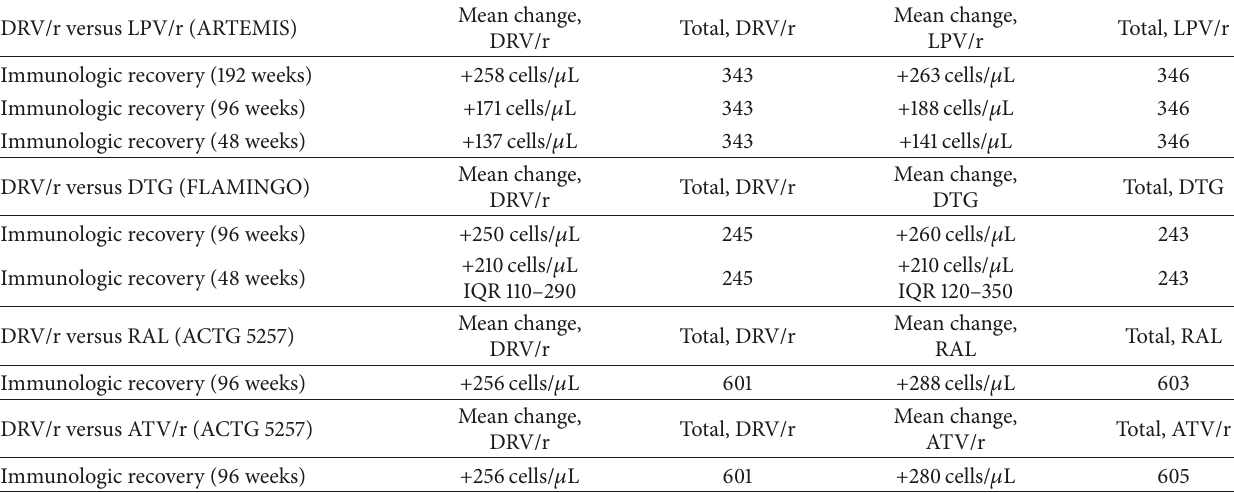
Table 3: Quantitative data for trial outcomes (continuous).